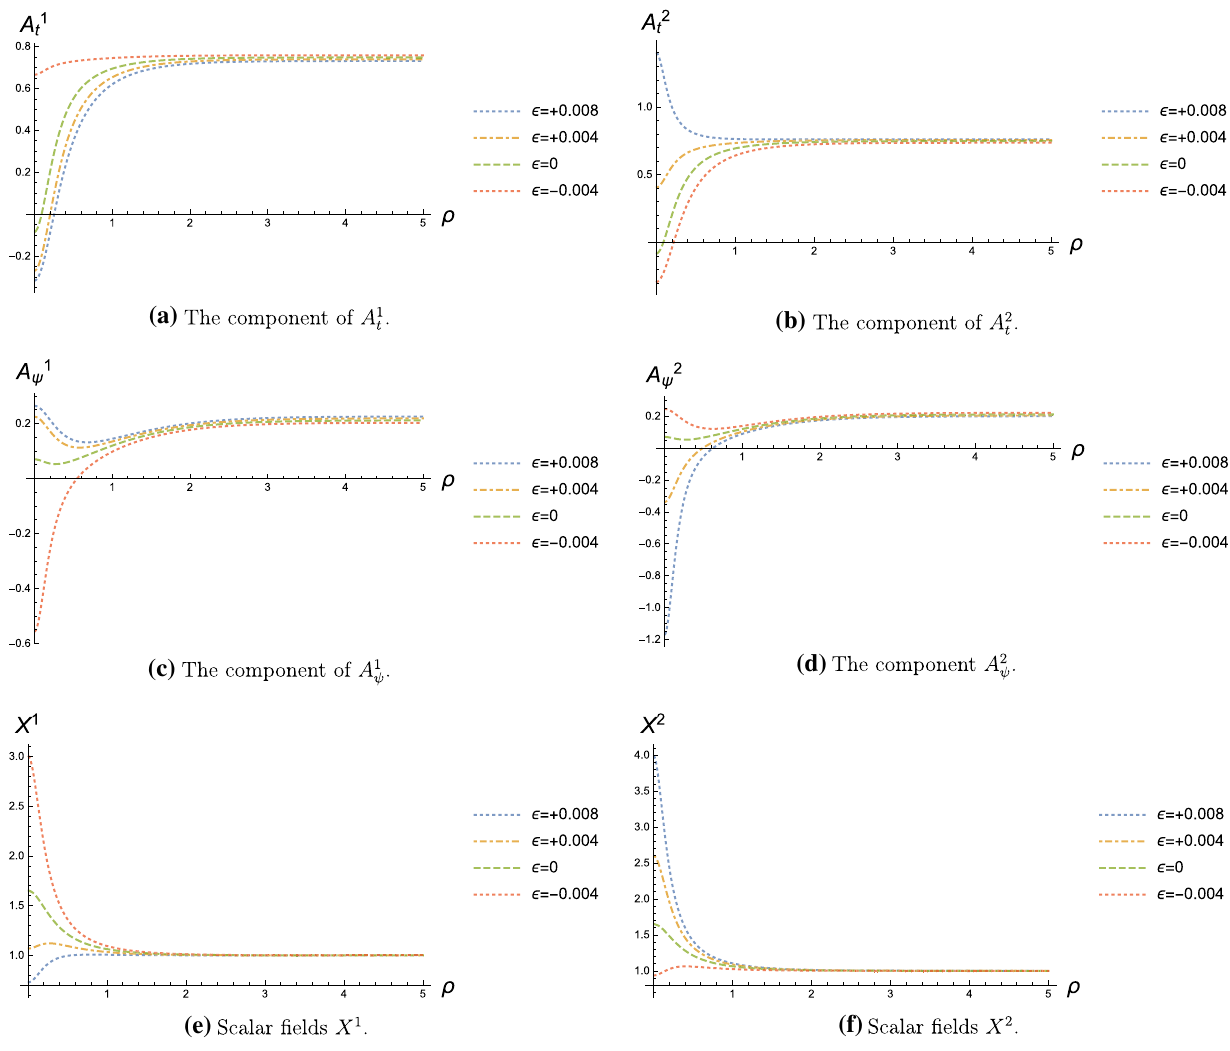
for various (cid:14) . It is evident that in the near-horizon region the 4